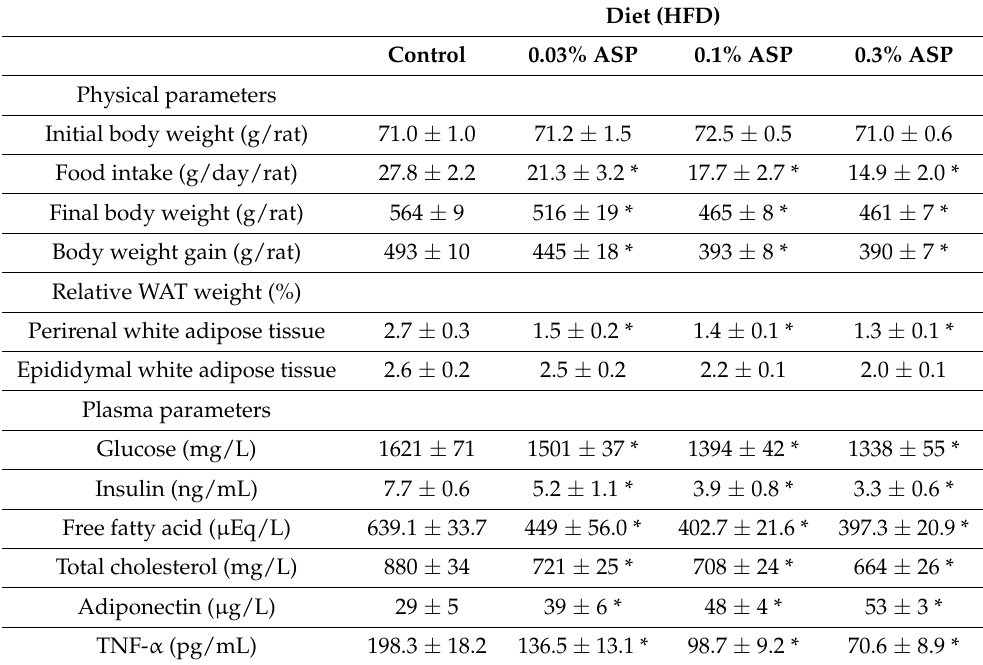
Table 5. Effects of ASP on physical and plasma parameters after a three-month administration in HFD-fed rats.